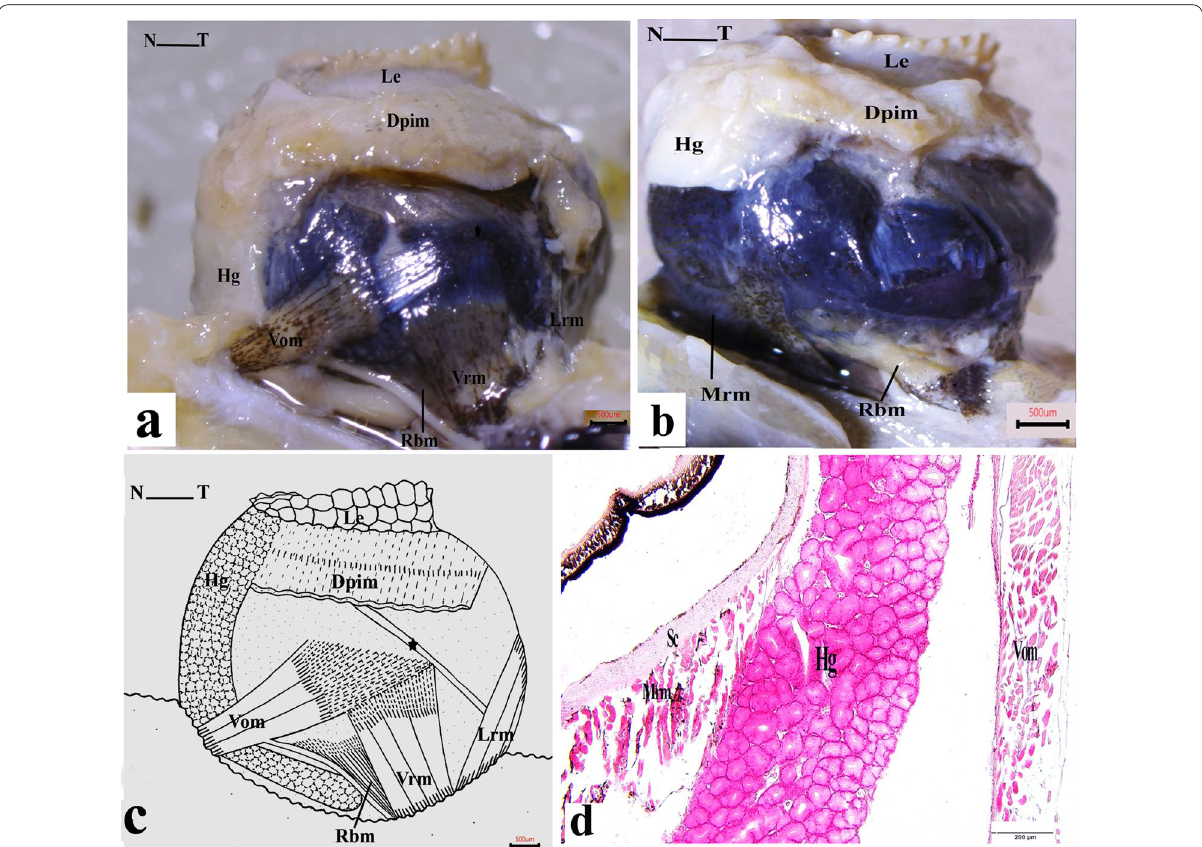
Fig. 2 A photomacrograph of the ventral view of the eye of Egyptian agama, Trapelus mutabilis , a after removing the partially depressor palpebral inferioris muscle (Dpim), b after the cutting ventralis oblique muscle (Vom), c drawn to clarify ( a ), d transverse section of the eye of Egyptian agama, Trapelus mutabilis , showing the localization of the Harderian gland (Hg) between the ventralis oblique muscle (Vom) and the medialis rectus muscle (Mrm) that attach on sclera cartilage (Sc) (H &E, 100), lower eyelid (Le), ventralis rectus muscle (Vrm), and retractor bulbi muscle ×